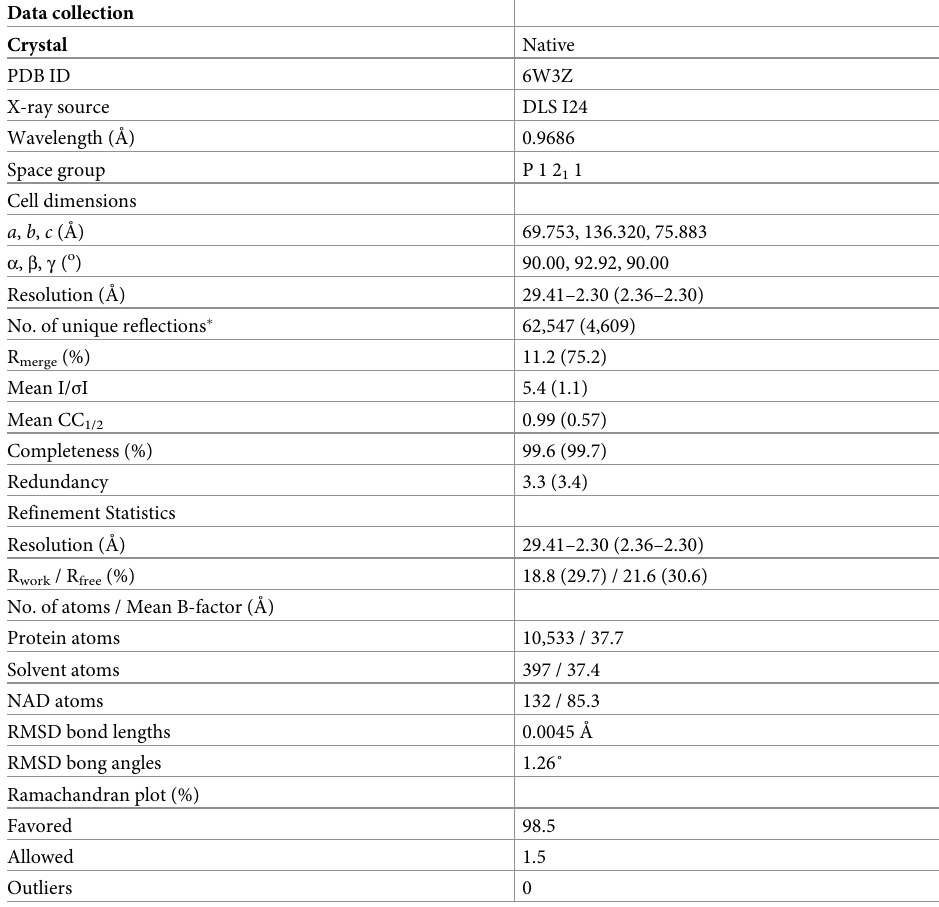
Table 3. Crystallographic data and refinement statistics for BmDHS-NAD +